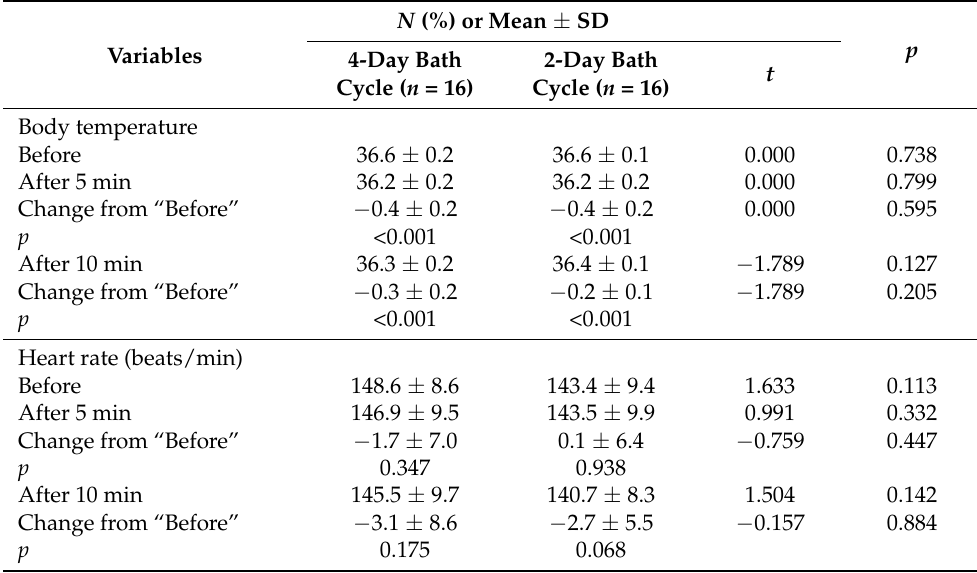
Table 2. Comparisons of physiological responses by groups and variables (N =